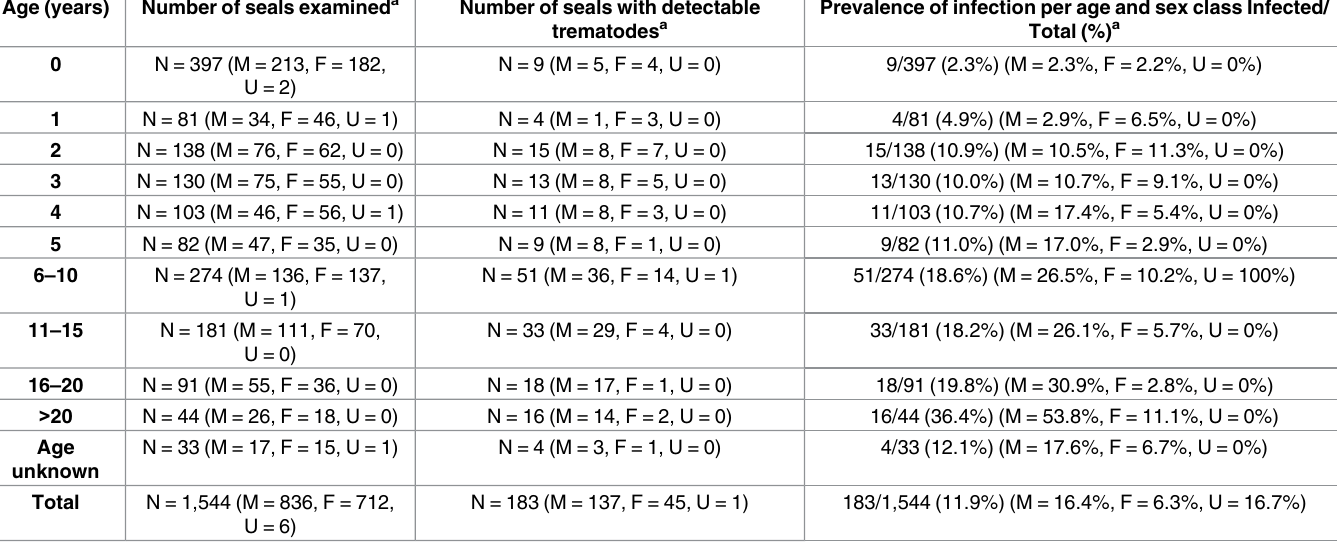
Table 1. Prevalence of Pseudamphistomum truncatum infection by age and sex class of grey seals ( Halichoerus grypus ) examined from the Swedish Baltic Sea